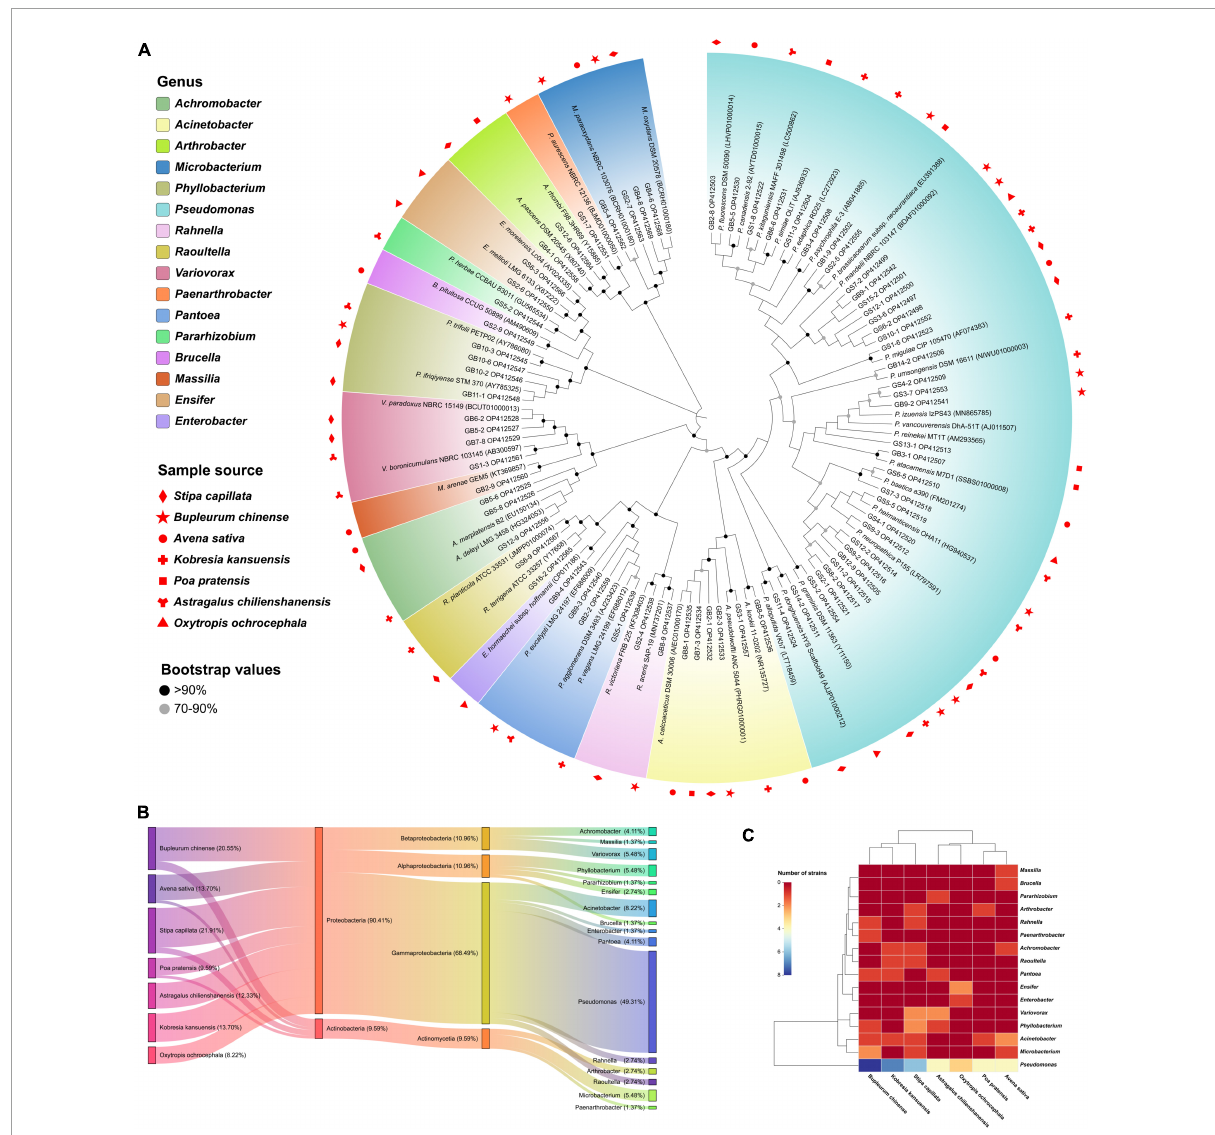
FIGURE1 Diversity and taxonomic analysis of phytase-producing bacteria. (A) Neighbor-joining tree based on 16S rRNA gene sequences showing relationships between the 73 isolates and their closest relatives, the effective sequence length was 1,200 bp and the bootstrap values were 1,000 replications. The serial number in parentheses denotes the GenBank accession number of strains. (B) Sankey diagram of the community composition of bacteria isolates. From left to right: Host plant, phylum level, class level, and genus level. (C) Abundance and hierarchical clustering analysis of bacteria isolates under different plants treatment at genus